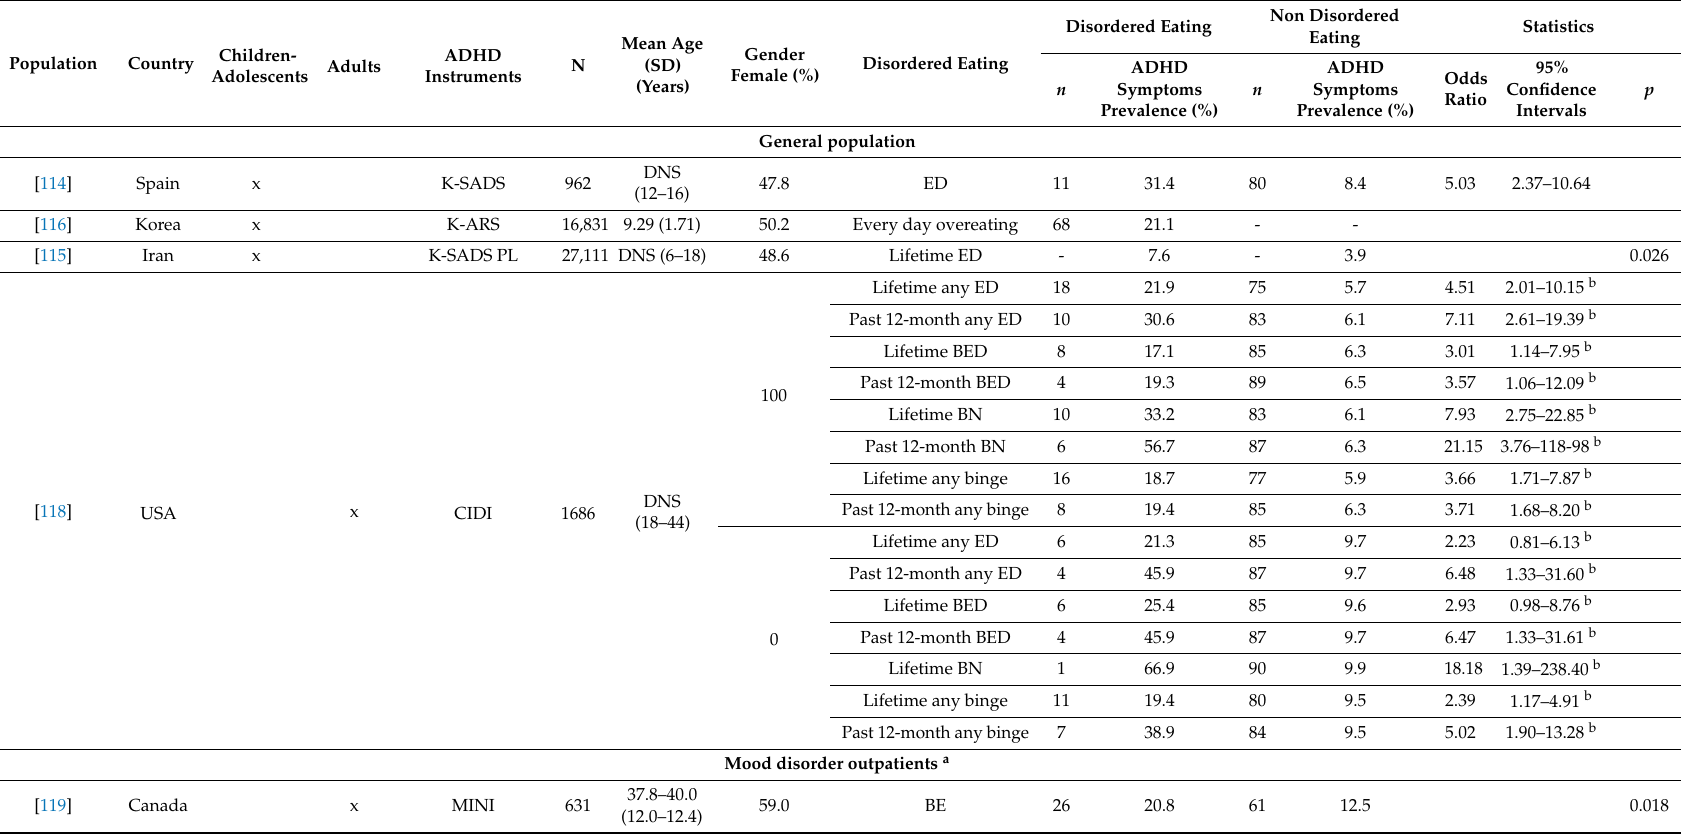
Table 4. Attention-Deficit Hyperactivity Disorder prevalence among disordered